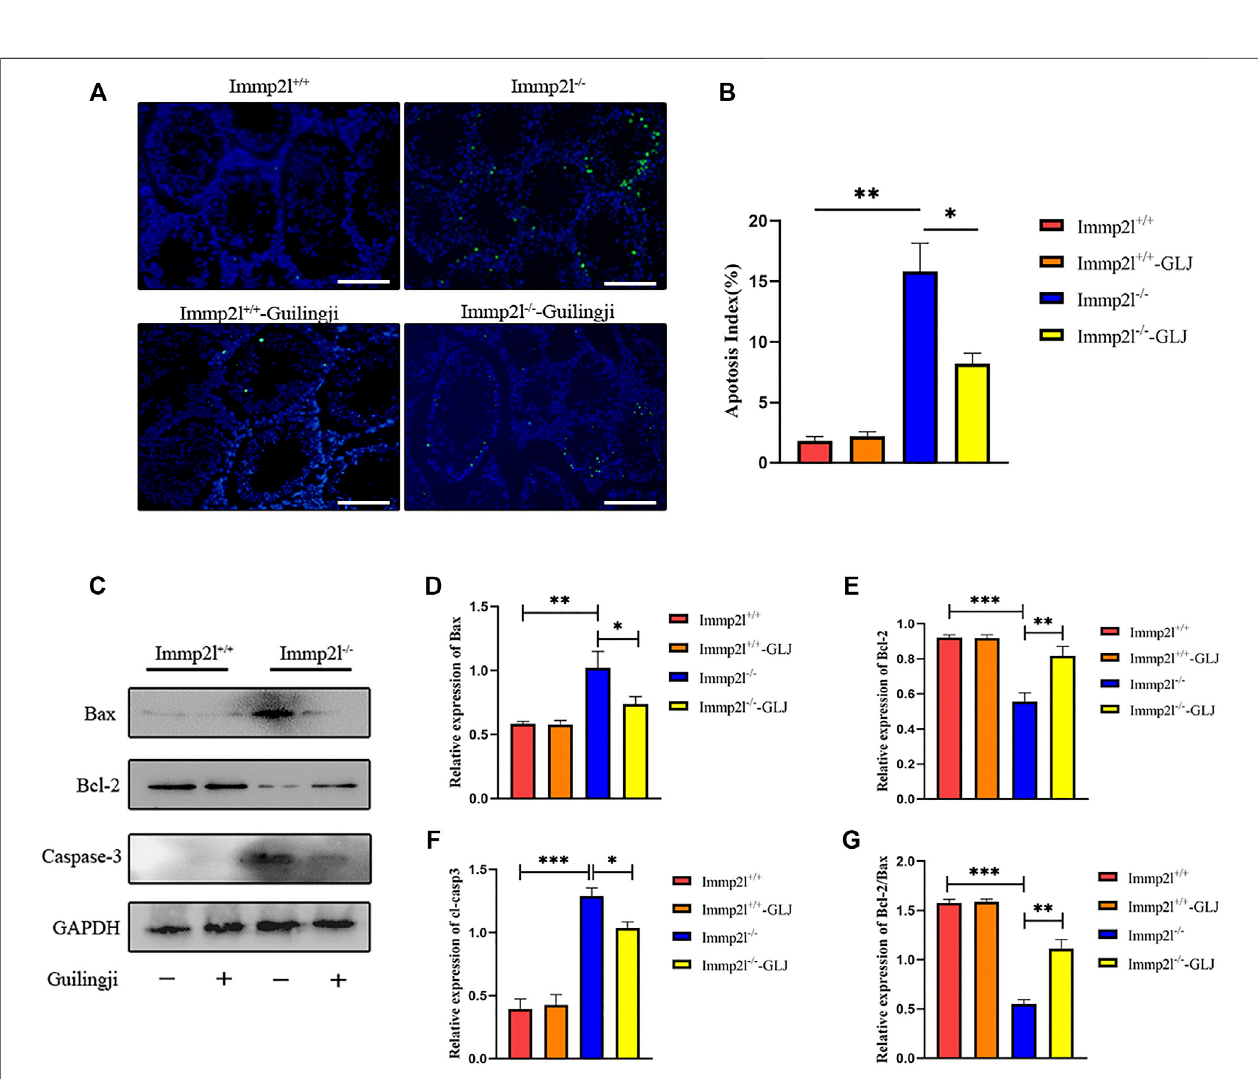
FIGURE 4 | The effects of Guilingji against cell death in testis. (A) TUNEL staining. Scale bar (cid:1) 50 μ m. (B) The percentage of TUNEL-positive cells within all cells in the slice. The bars showed means ± SEM. * p < 0.05, ** p < 0.01. n (cid:1) 5. (C) Western blotting was used to analyse proteins extracted from the testis of mice. The relative intensities of (D) Bax, (E) Bcl-2, (F) Caspase-3 and (G) the Bcl-2 to Bax ratio. The bars showed means ± SEM of three independent experiments. * p < 0.05, ** p < 0.01, *** p < 0.001. n (cid:1) 3.